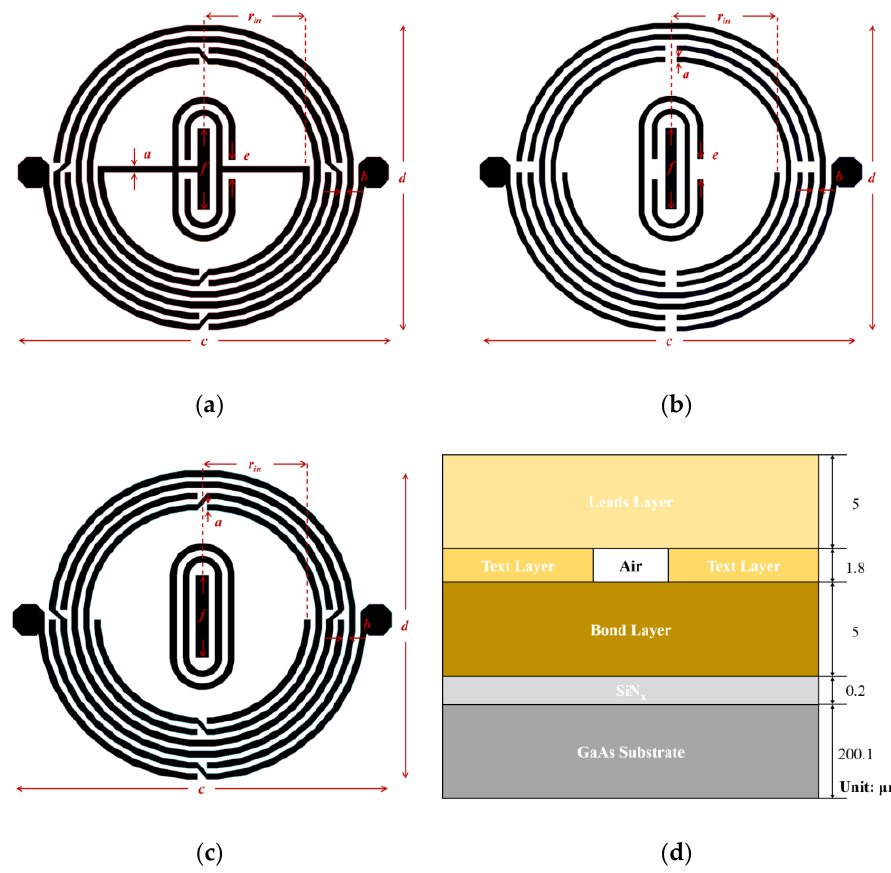
Figure 2. Configuration of the ( a ) Bond layer, ( b ) Text layer, and ( c ) Leads layer, and ( d ) a cross-sectional view of the fabricated integrated passive device (IPD) chip.